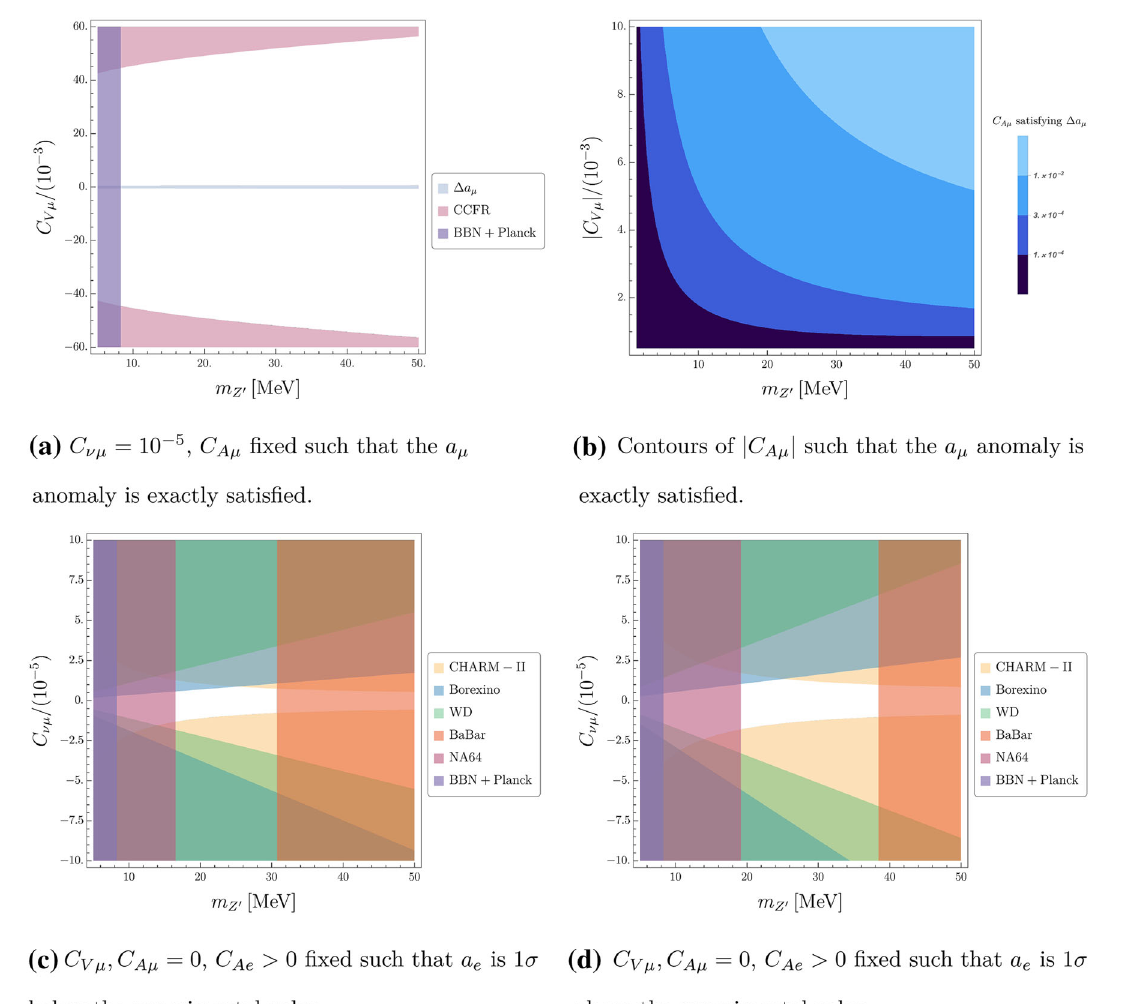
Fig. 3 Constraints on the mass and effective couplings of the Z (cid:2) in the muon sector. In a we have set C νμ = 10 − 5 fixed C A μ so that the a μ anomaly is exactly satisfied, while in b we show contours of the values of | C A μ | this corresponds to, as a function of | C V μ | and m Z (cid:2) . In the